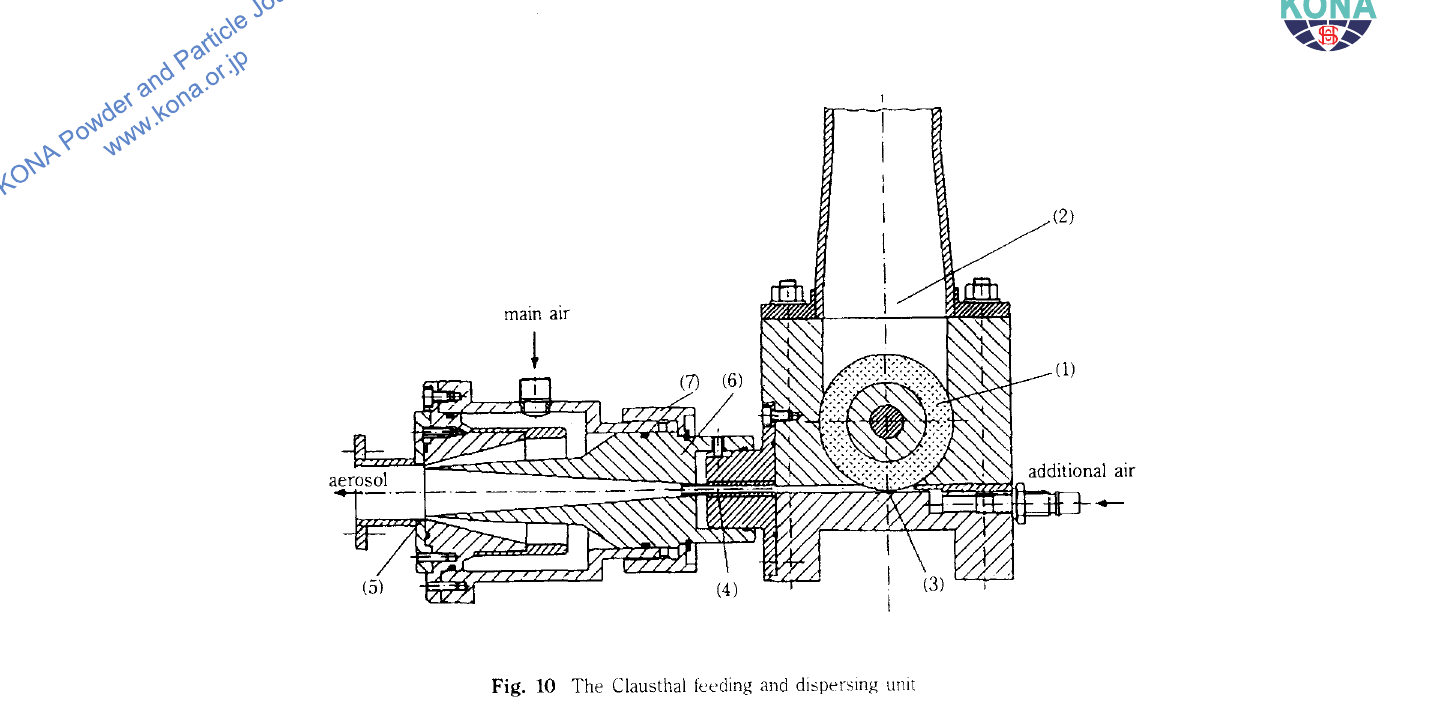
Fig. 10 The Clausthal feeding and dispt>rsmg umt